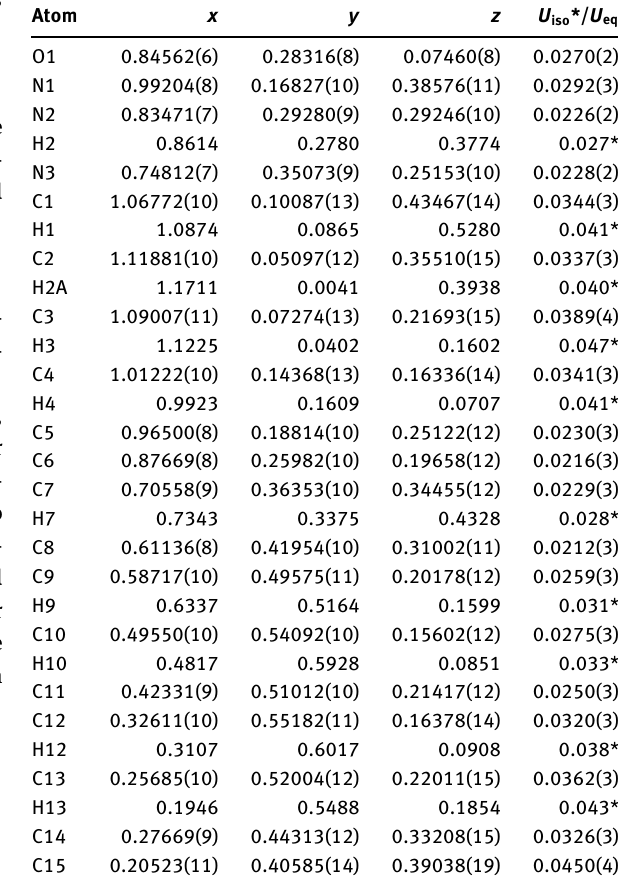
Table 2: Fractional atomic coordinates and isotropic or equivalent isotropic displacement parameters (Å 2